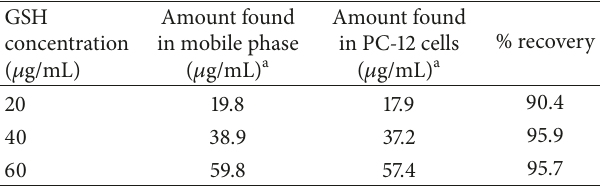
Table 3: Recovery of GSH from PC-12 cells after spiking